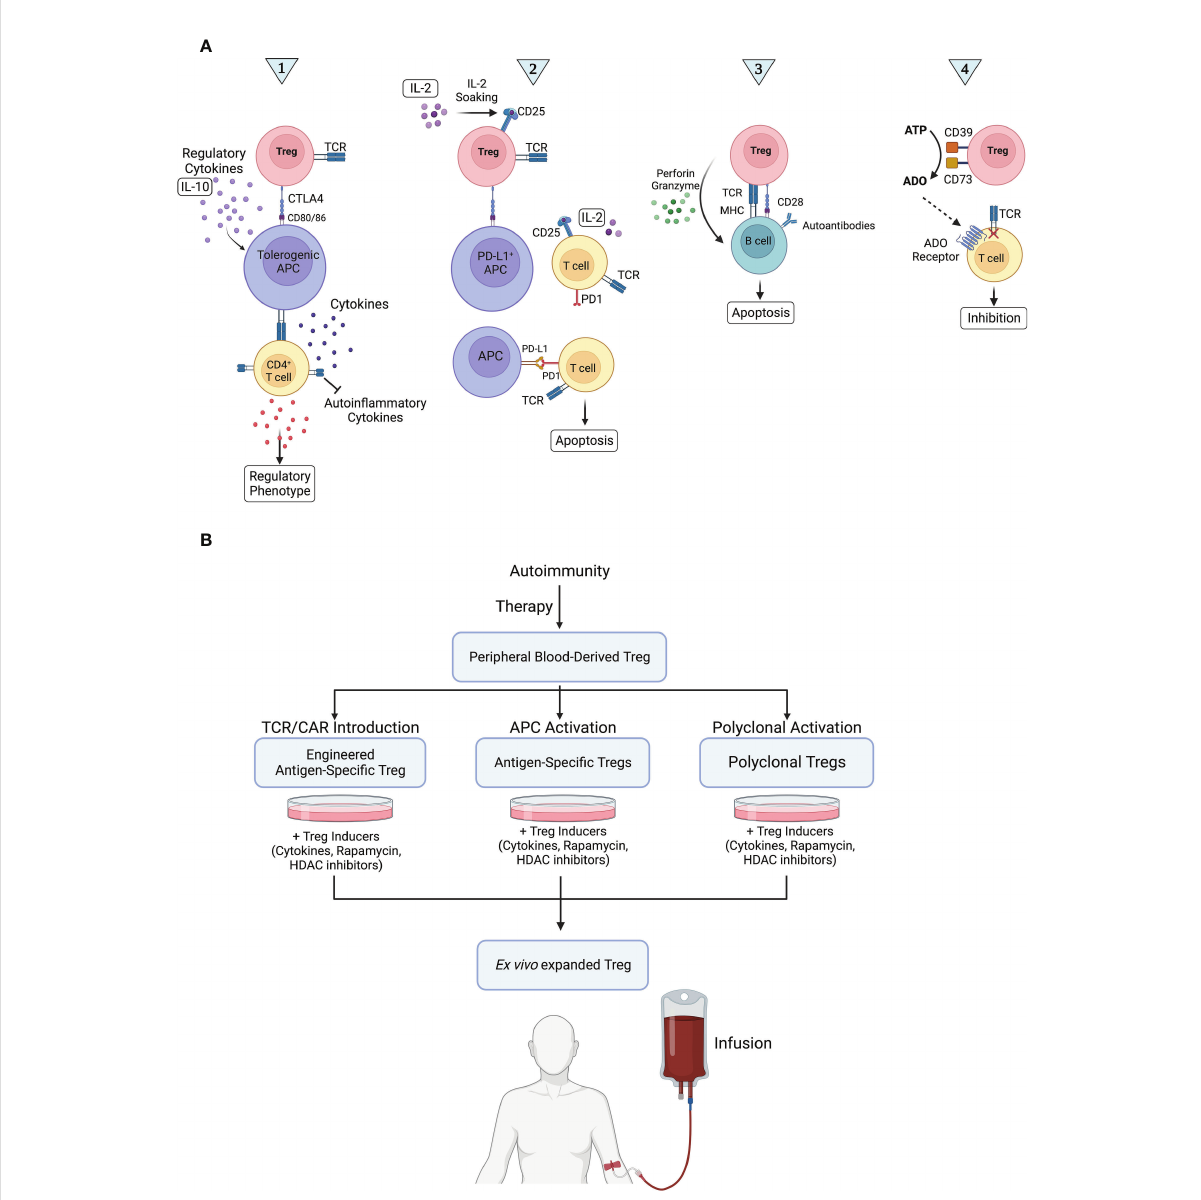
FIGURE 1 Treg cell mechanisms of action in autoimmunity and therapeutic application. (A) Treg cells are thought to work via four main routes. Route 1: Treg cells expand and secrete large amounts of IL-10, enhancing tolerogenic APC activity. Tolerogenic APCs in turn interact with CD4 + T cells, inhibiting their release of self-in fl ammatory cytokines. In addition, tolerogenic APCs stimulate the development of a regulatory phenotype in naïve T cells and induce the production of Treg cells, ultimately suppressing autoimmune reactions. Route 2: The release of IL-2 in the microenvironment is detected by CD25 + Treg cells, which interact with and induce PD-L1 expression in APCs. PD-L1 + APCs then induce apoptosis in activated PD-1 + Teff cells via PD-1/PD-L1 signaling, inhibiting immune responses, such as those targeting self-antigens. Route 3: The interaction of Treg cells with autoreactive B cells induces B cell apoptosis via perforin/granzyme-mediated cytotoxicity, preventing autoantibody production. Route 4: Treg cells convert extracellular ATP into adenosine (ADO), a potent immunosuppressant, using ectoenzymes CD39 and CD73. ADO binds to its receptor in Teff cells, inhibiting them. (B) Any disruption in routes 1, 2, 3, and 4 can lead to autoimmunity. In Treg cell-based therapy, Treg cells are collected from peripheral blood, activated, and expanded ex vivo . Finally, Treg cells are injected to suppress immune responses via routes 1, 2, 3, and